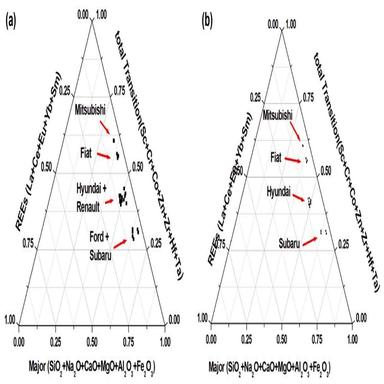
Ternary plots of all glasses of (a) 6 brands and (b) 4 brands.